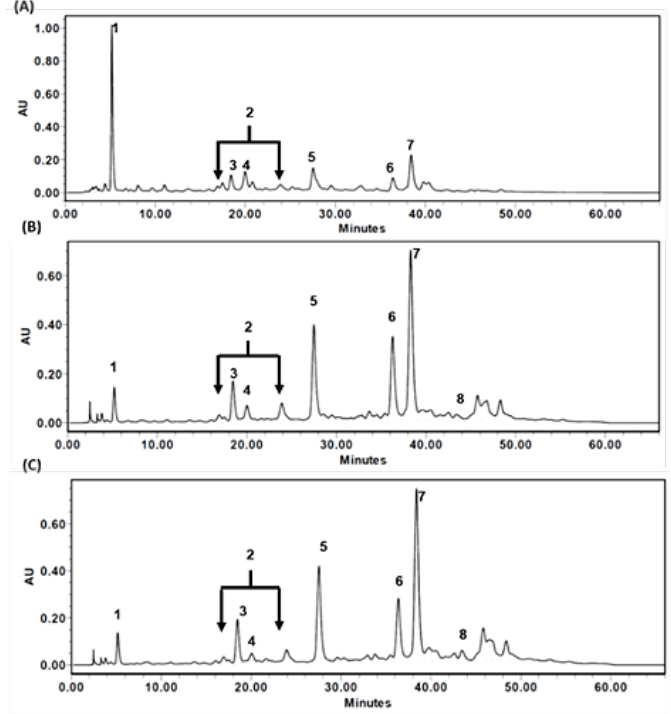
Figure 3. The profiles of HPLC chromatograms of ( A ) TT-hull-HWE; ( B ) TT-hull-50EE; ( C ) TT-hull-95EE. The identified peaks were as follows: Peak 1, gallic acid (as TT-6); Peak 2, tellimagrandin I (as TT-8); Peak 3, 1,6-di-O-galloyl- β -D-glucopyranoside (as TT-5); Peak 4, 1,2,3-tri-O-galloyl- β -D-glucopyranoside (as TT-3); Peak 5, 1,2,6-tri-O-galloyl- β -D-glucopyranoside (as TT-4); Peak 6, tellimagrandin II (as TT-1); Peak 7, 1,2,3,6-tetra-O-galloyl- β -D-glucopyranoside (as TT-2); and Peak 8, 1,2,3,4,6-penta- Ο -galloyl- β -D-glucopyranoside (as TT-7).